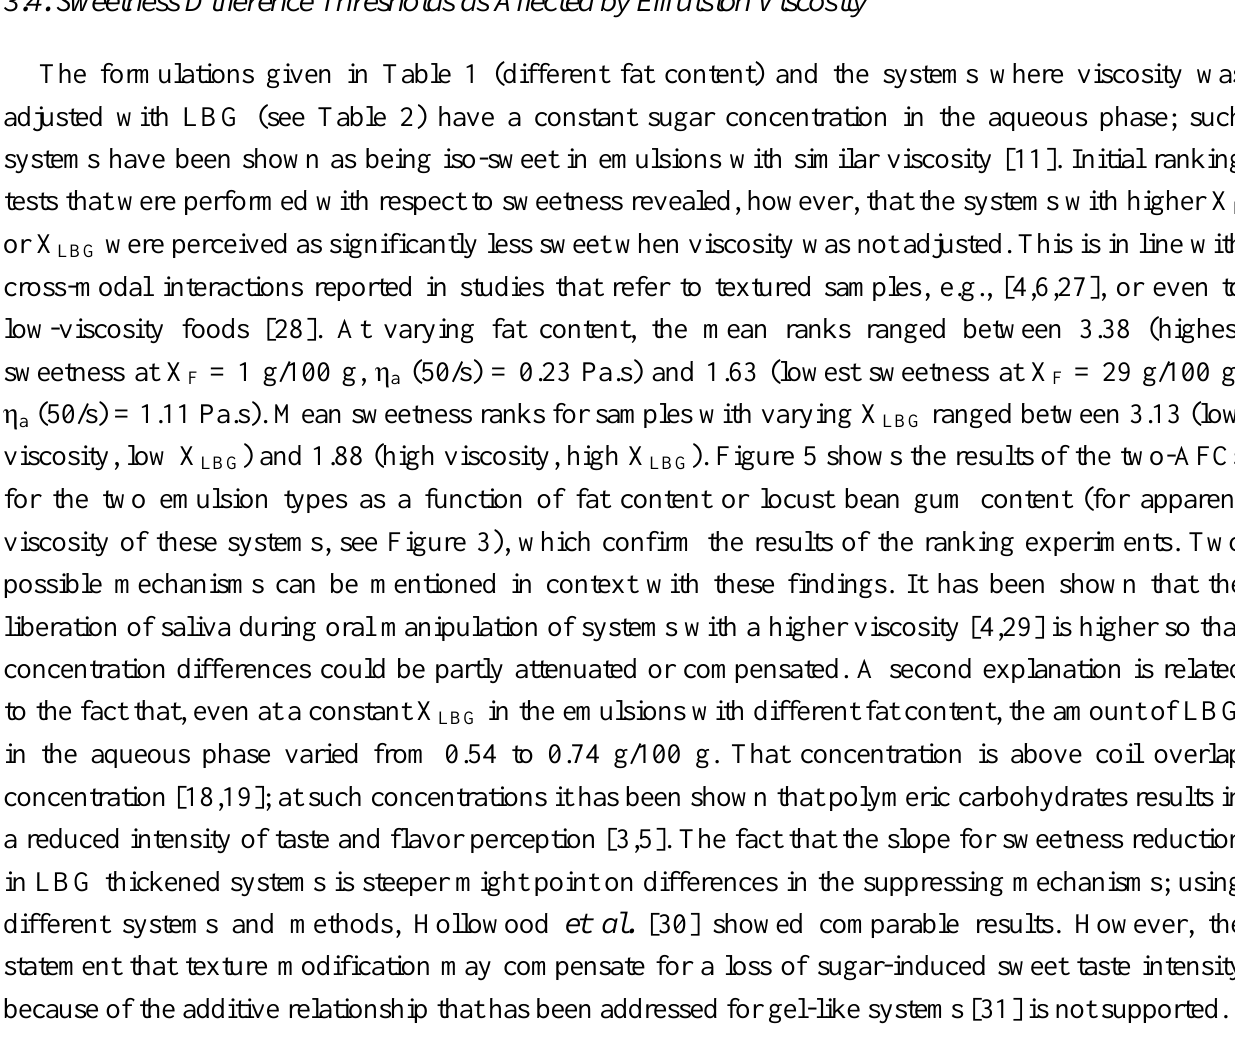
Figure 5. Judgment of sweetness of emulsions with different viscosity. Viscosity was adjusted by using different levels of fat or locust bean gum. The fraction of sugar in the aqueous phase was 0.05. Reference samples (full symbols) contained 5 or 15 g/100 g fat, or 0.57 or 0.72 g/100 g locust bean